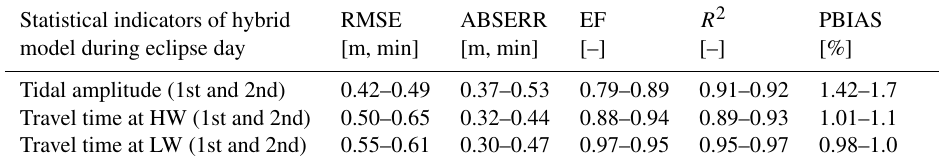
Table 6. Statistical indicators of analytical hydrodynamic model performance during the supermoon total lunar eclipse day. Statistical indicators of hybrid